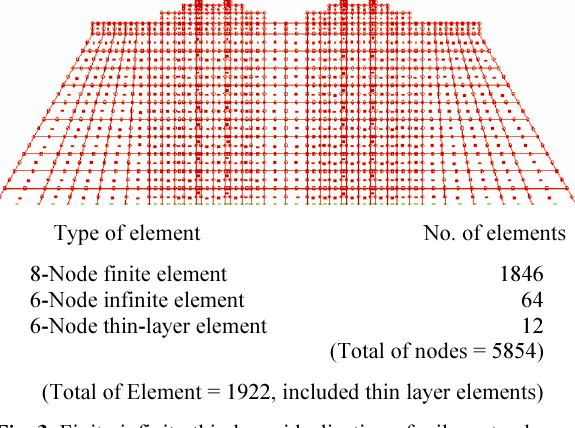
Fig. 3. Finite-infinite-thin layer idealization of railway track sleeper-ballast-sub-ballast-supporting media